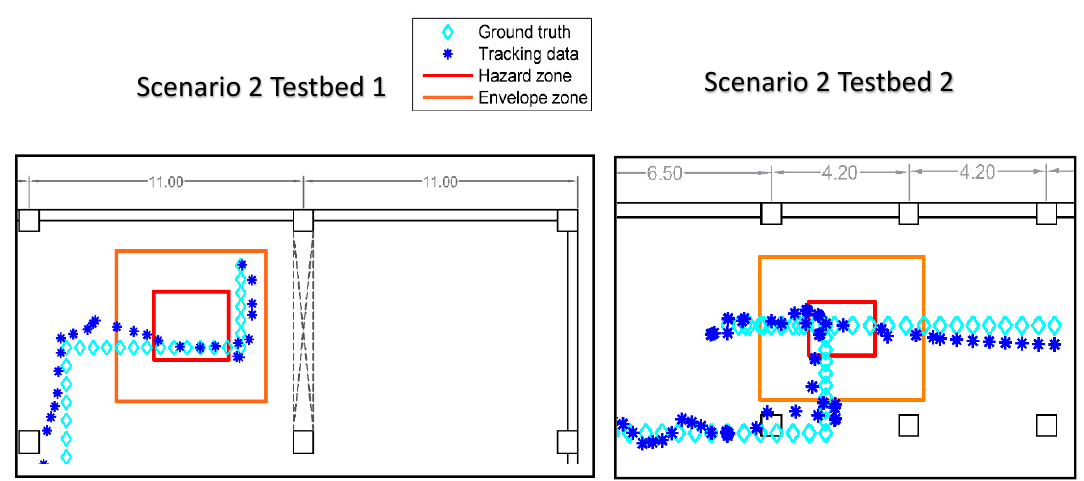
Figure 7. Zoomed-in view of tracking results and the corresponding ground truths of certain test cases.